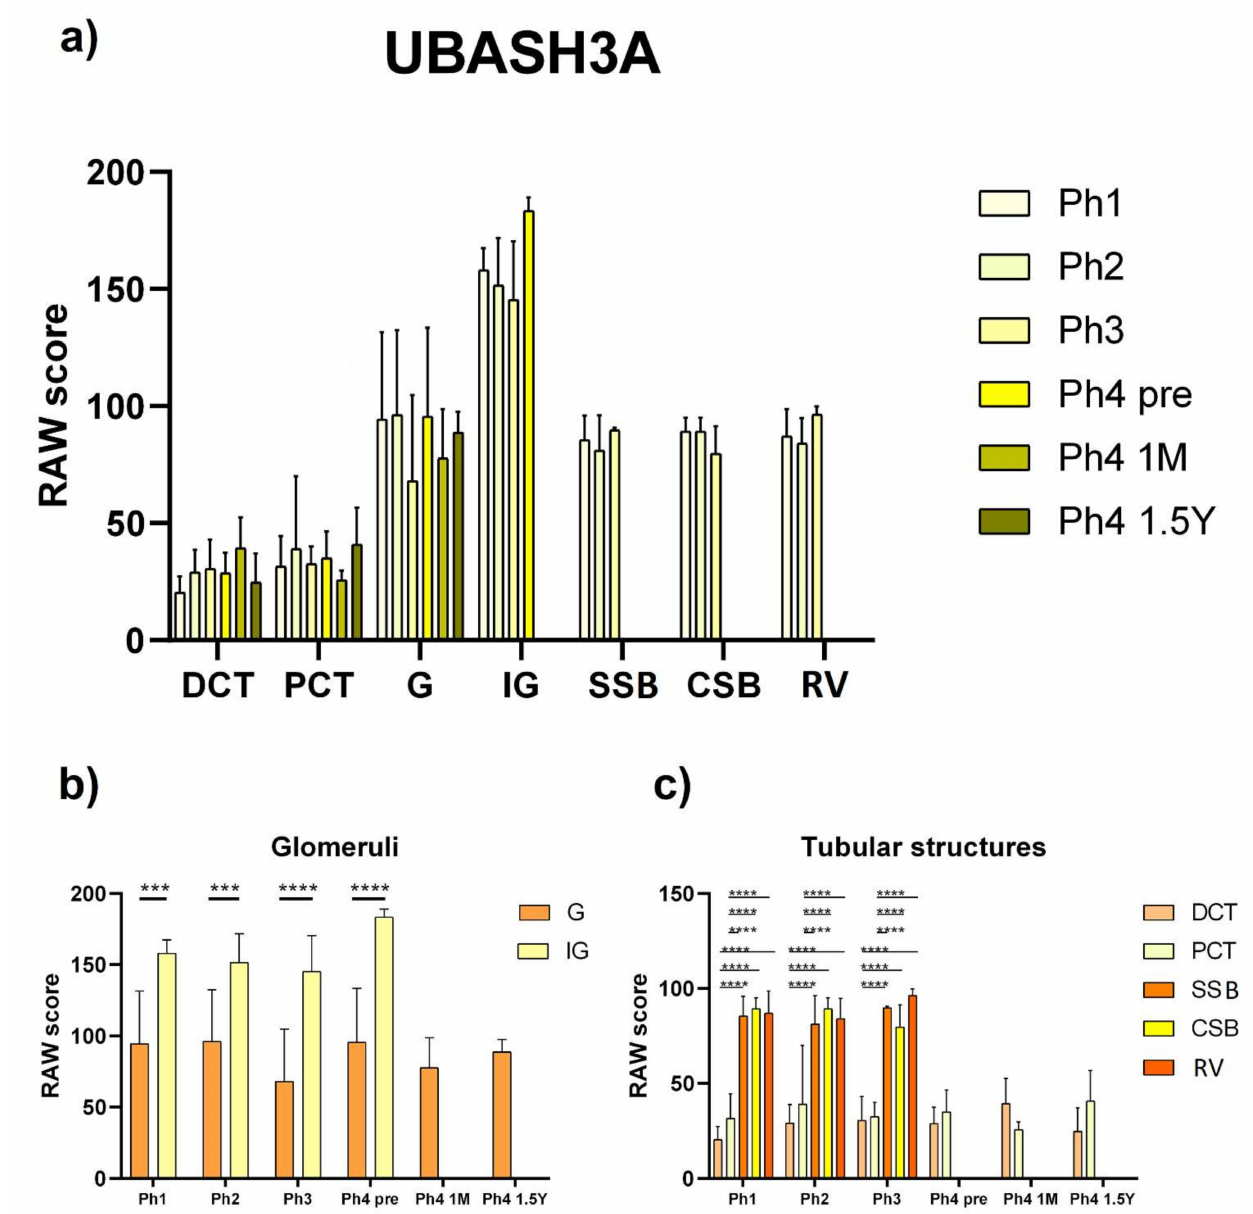
Figure 9. RAW scores of UBASH3A in the cortical nephron structures of human fetal and postnatal kidneys. Fully differentiated glomeruli (G), proximal convoluted tubules (PCT), distal convoluted tubules (DCT), immature glomeruli (IG), S-shaped bodies (SSB), comma-shaped bodies (CSB) and renal vesicles (RV), phase one (Ph1), phase two (Ph2), phase three (Ph3), phase four prenatal (Ph4 pre), phase four one month postnatal (Ph4 1 M), and phase four one and a half years postnatal (Ph4 1.5 Y). For statistical analyses, enough developmental structures (IG, SSB, CSB, and RV) were found only in the first three phases. Data are presented as the mean ± SD (vertical line) and analyzed by the two-way ANOVA test with Tukey’s multiple comparisons test. Significant differences were indicated by ** p < 0.01, *** p < 0.001, **** p < 0.0001. ( a ) Comparison of structures from different periods. ( b ) Comparison of mature and immature glomeruli from the same period. ( c ) Comparison of DCT, PCT, SSB, CSB and RV from the same